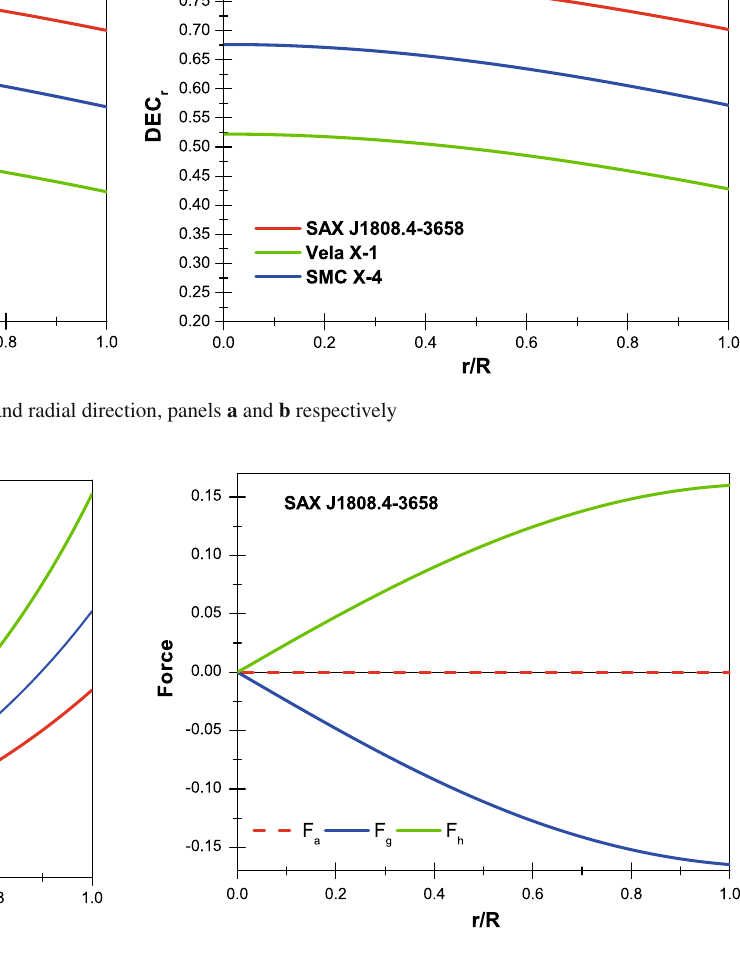
Fig. 16 TOV equation for the strange star candidate SAX J1808.4- 3658 versus the fractional radial coordinate for α = 0 .